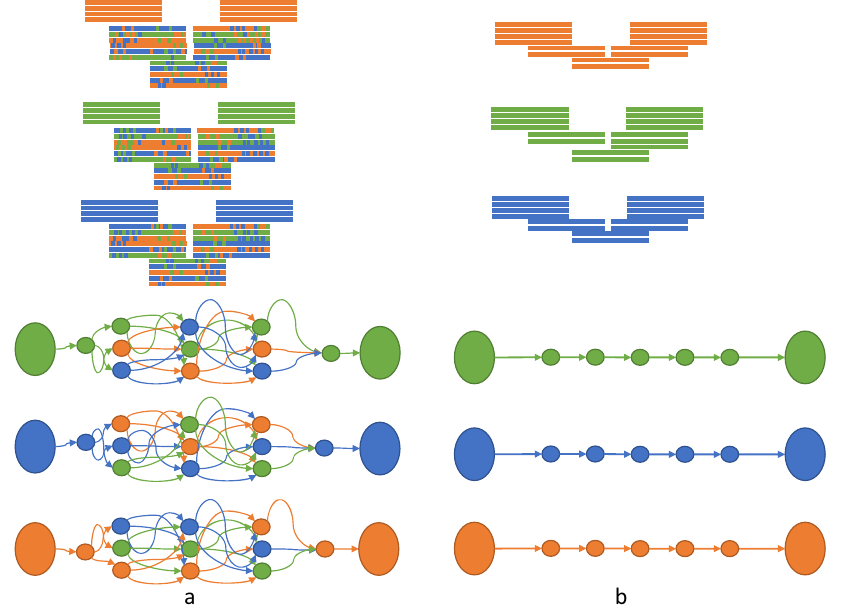
Fig. 6 | ComparisonoftheoverlapgraphsusedbyMiniasm duringassemblyof a region in the C. elegans genomes when the chromosome-by-chromosome strategy is applied or not. a In the whole genome assembly mode, the overlap